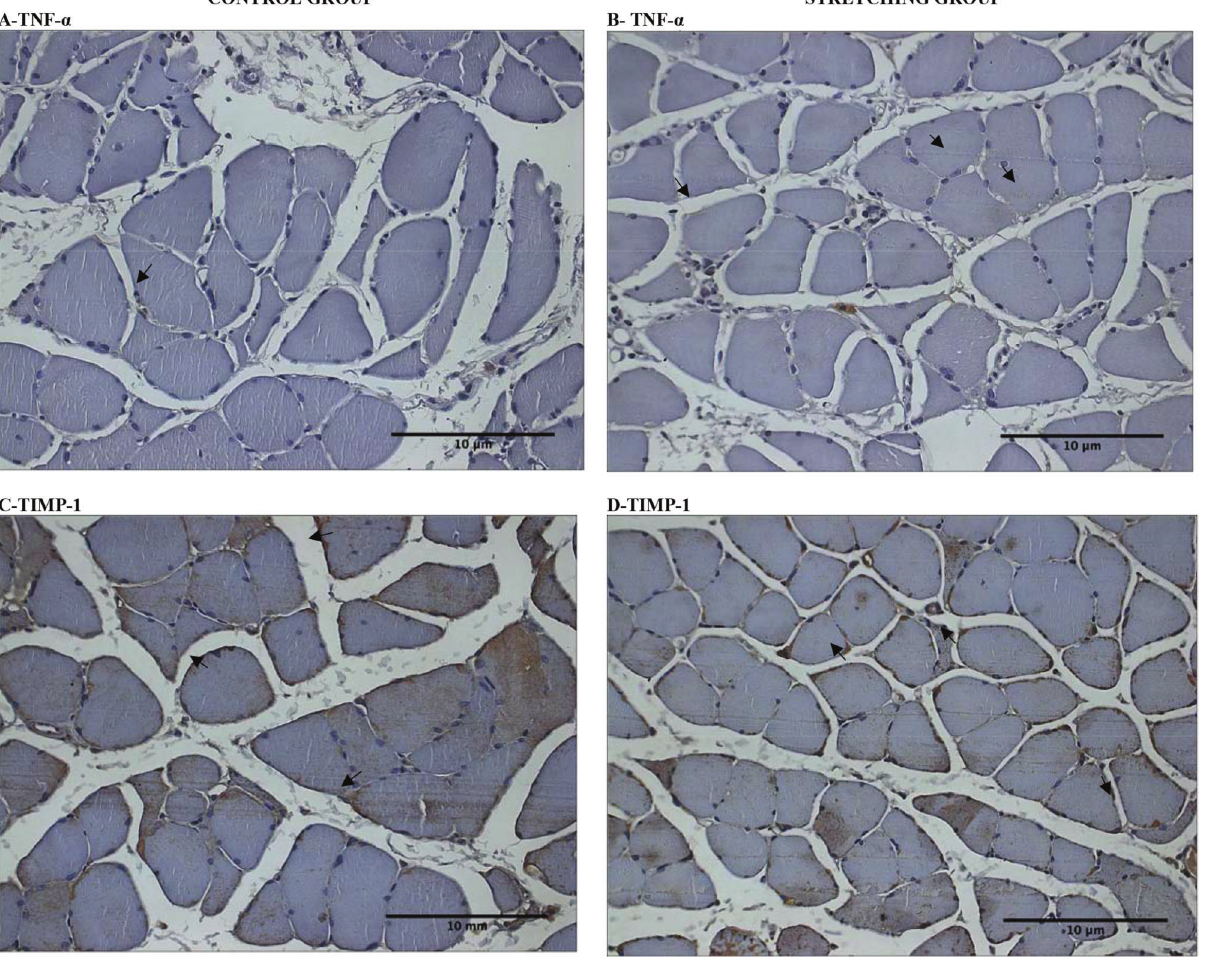
Figure 1 - Photomicrographs (x400) of the soleus muscle cross-sections immunostained for TNF- a and TIMP-1. Immunostains are indicated by arrows ( - ). Scale bar 10 m m (—).